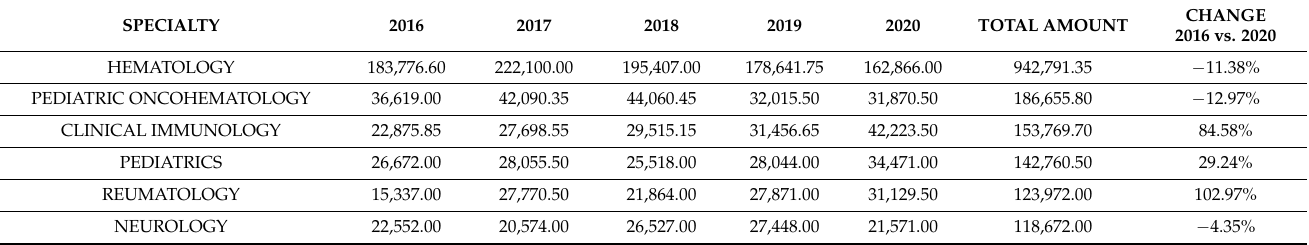
Table 1. Annual consumption of immunoglobulins in grams, total consumption from 2016 to 2020, and change in consumption over this period (2020 vs. 2016) by specialty. NR not